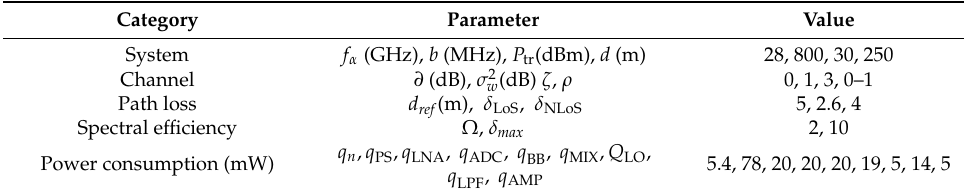
Table 7. System parameters.